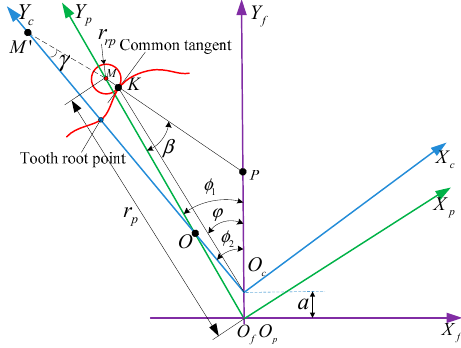
Figure 1. Meshing motion relationship of cycloidal-pin gear.